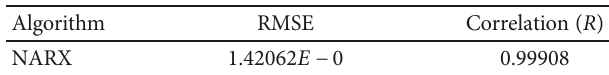
Figure 17: The error, output, and target power loss of model. Table 2: RMSE and